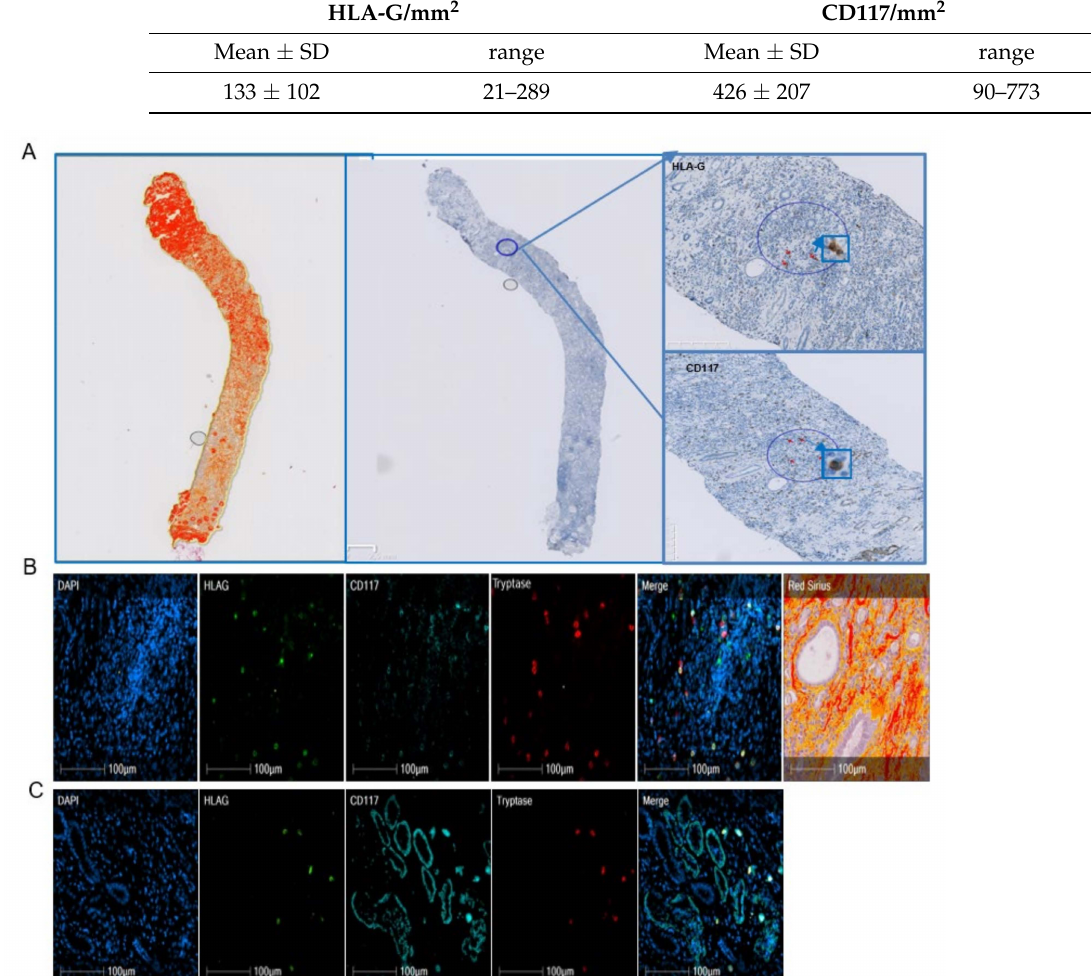
Figure 3. Nature of HLA-G cells on a representative case of renal fibrosis. ( A ) In the first paragraph, the photo on the left shows the Sirius Red coloration, the middle photo shows the counterstain by Mayer hematoxylin using immunohistochemistry. The areas in circles are topographically corresponding to HLA-G and CD117 stained slides, with 4H84 recognizing HLA-G and CD117 recognizing c-kit cells. Red arrows are positive cells. The rectangles show a strong magnification of these areas indicating that HLA-G cells do not match CD117 cells. ( B ) Quadruple immunofluorescence on a representative case of liver fibrosis using DAPI with nuclei blue, HLA-G (with 4H84 antibody) with green pseudo-color, CD117 in cyan pseudo-color, mast cell tryptase in red pseudo-color, and the composite image or merge. On the right, Sirius Red is represented. Cells stained yellow on the merge are corresponding to HLA-G+ mast cells. ( C ) The areas stained cyan are corresponding to numerous tubules only expressing CD117. Cells stained yellow on the merge are corresponding to HLA-G+ mast